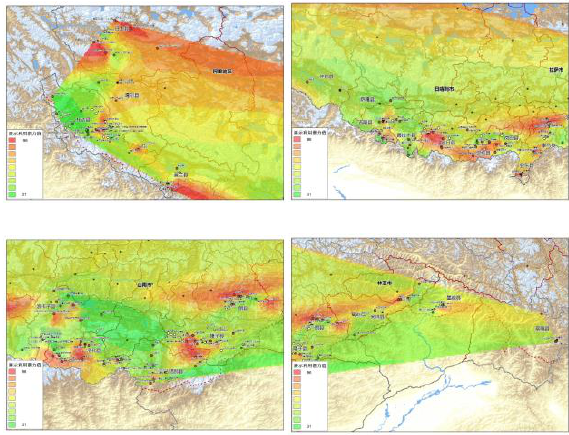
Figure 2. Natural neighbor interpolation analysis of utilization potential of Preservation Units